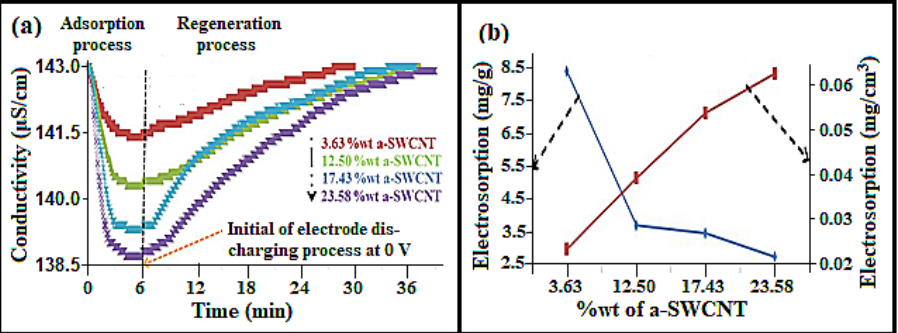
Figure 5. ( a ) Adsorption and release behaviour of various a-SWCNT-coated RVC electrodes at 1.5 volt, using 50 mL/min water flow-rate between electrode; and ( b ) the electrosorption capacity in terms of mass of a-SWCNTs and in terms of the geometric volume of the composite electrode at various loadings of a-SWCNTs on the RVC electrode using the CDI